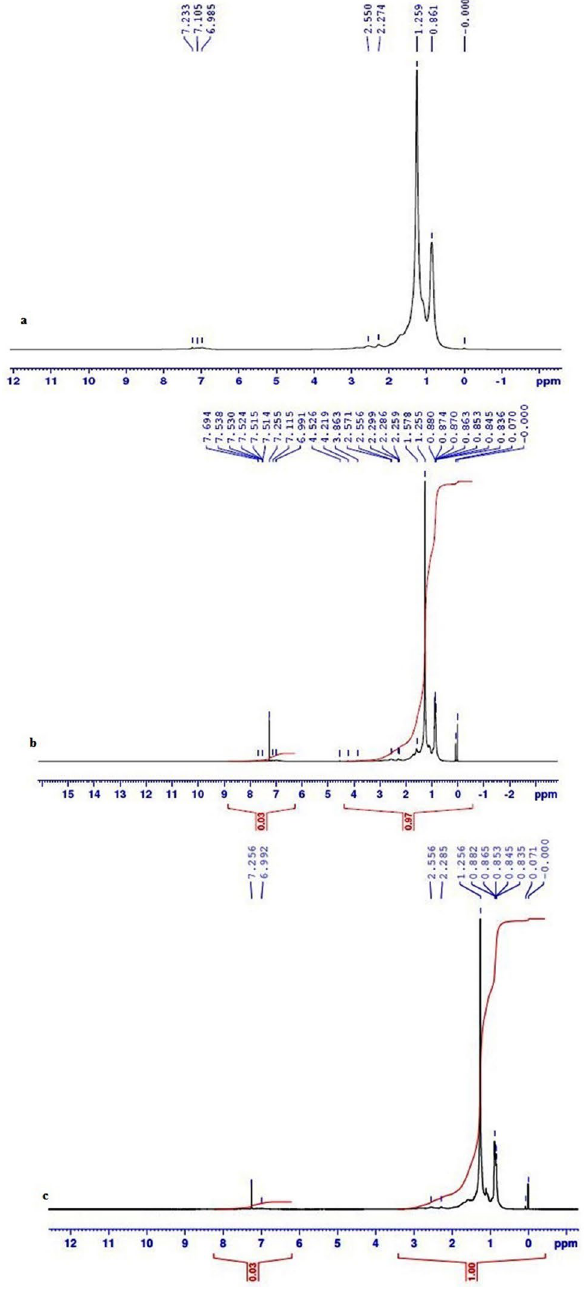
Figure 5. 1 H NMR analysis ( a ) SE oil, ( b ) degraded SE oil at 0.1 MPa and ( c ) degraded SE oil at 10 MPa pressure